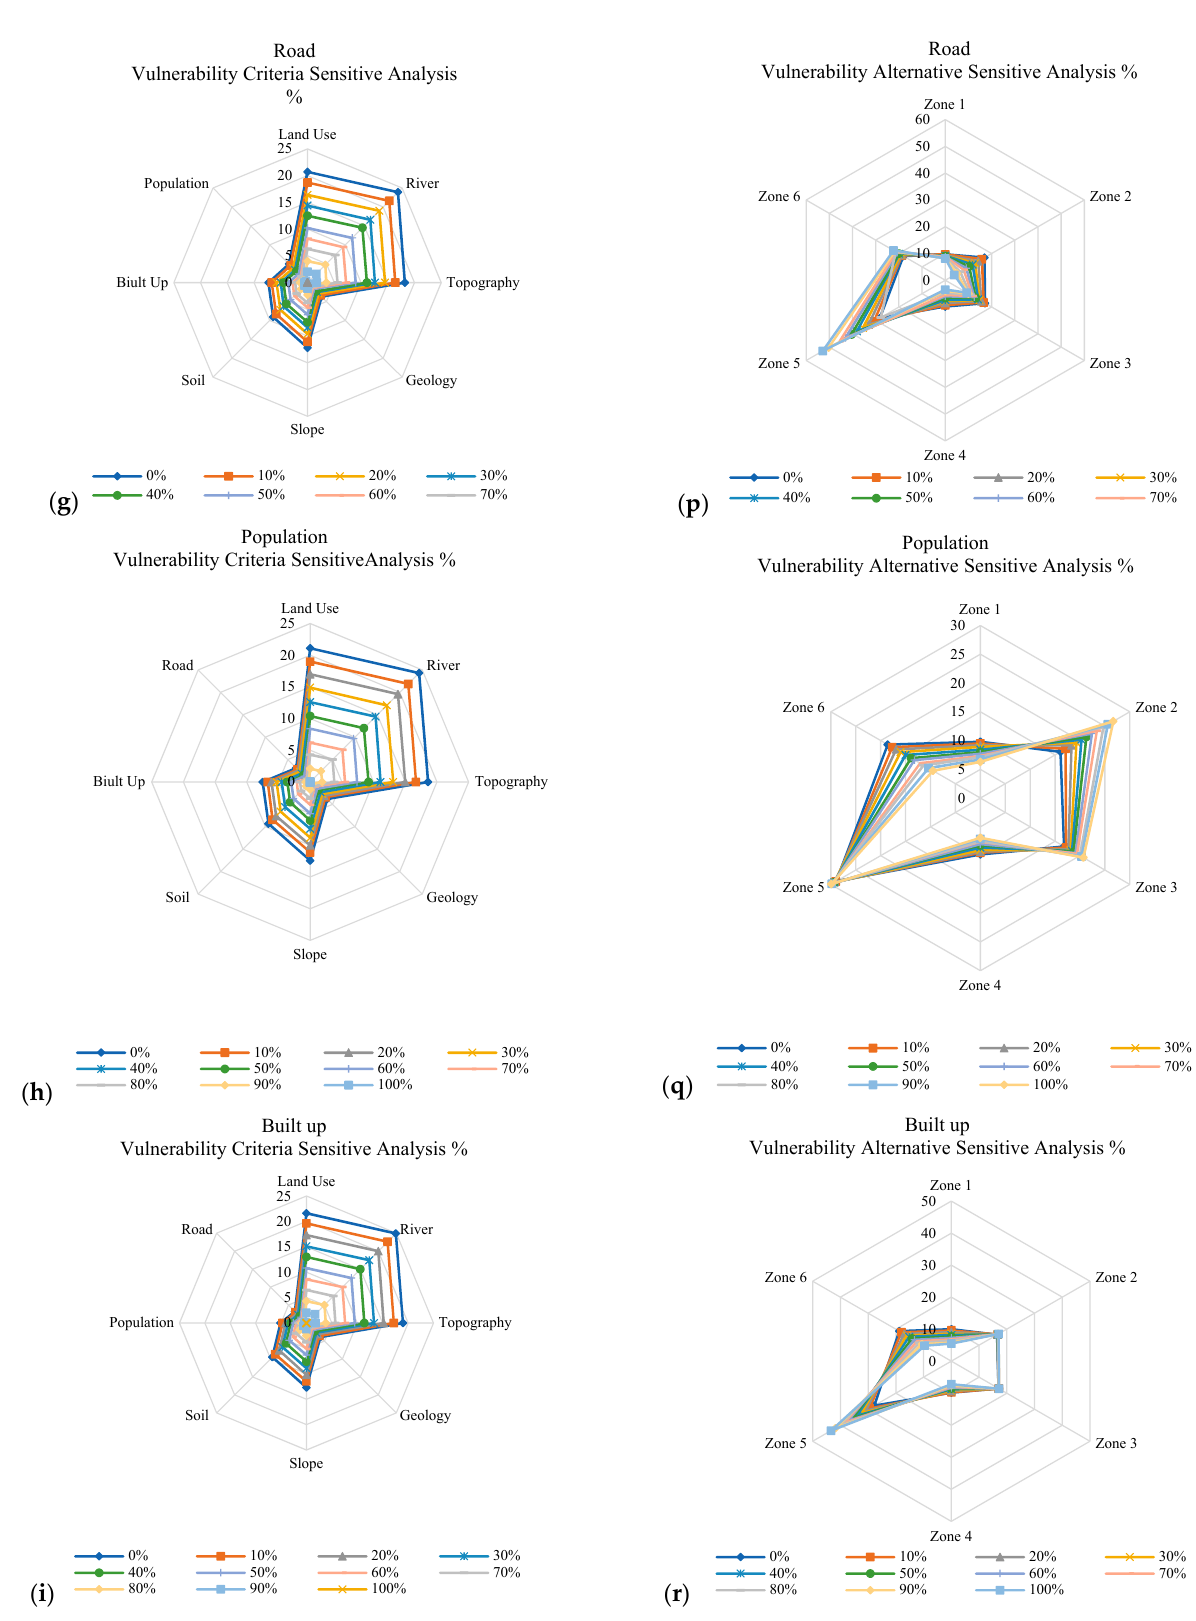
Figure 3. ( a – i ) Radar graph of the vulnerability criteria for coastal city erosion for Kuala Terengganu, Malaysia, as per sensitivity analysis conducted in Expert Choice software. ( j – r ) Radar sensitive graph between the vulnerability criteria and regions developed as an